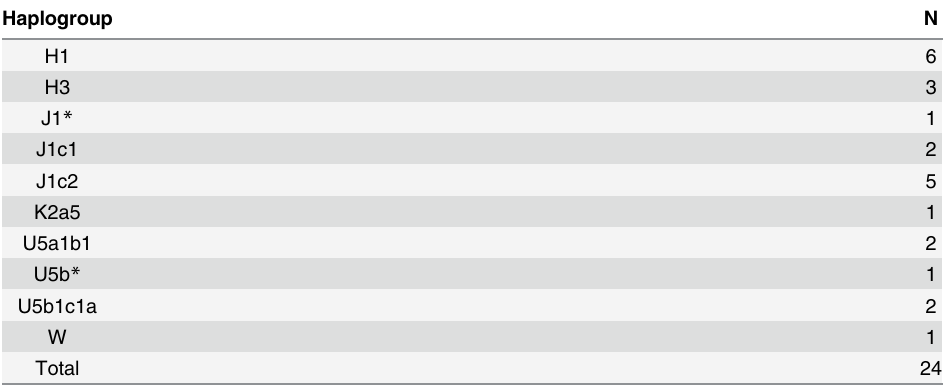
Table 1. Haplogroups identified in the sample set of La Hoya. N = number of individuals.